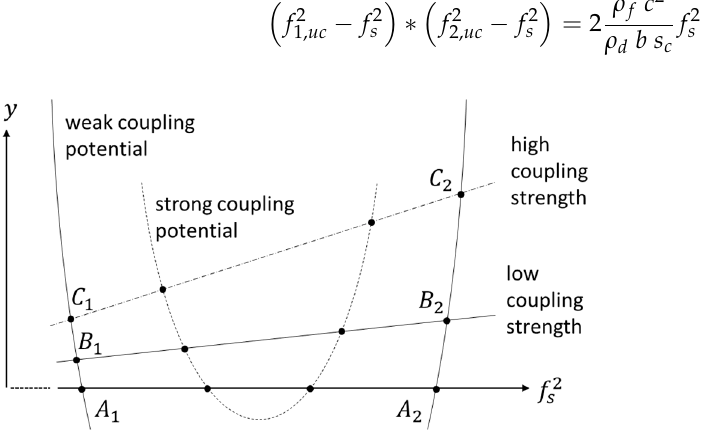
Figure 2. Coupling model of Magara et al. (2008)